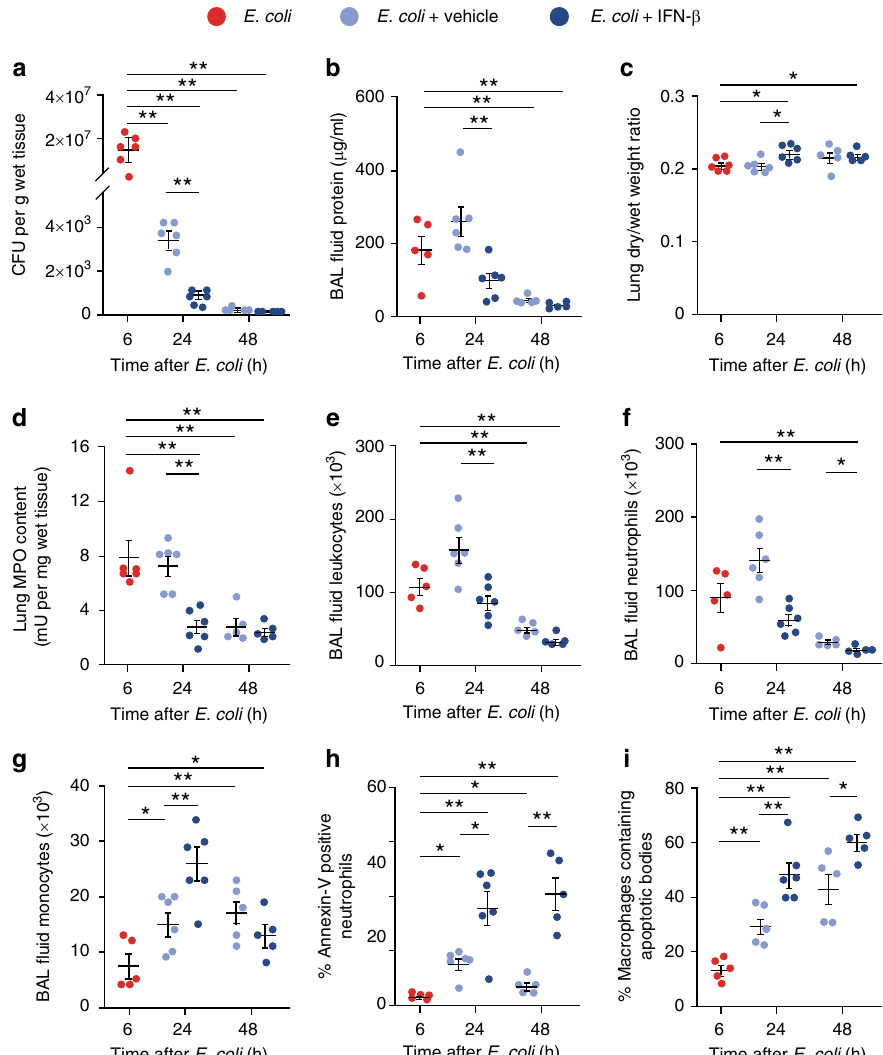
Fig. 8 IFN- β treatment accelerates the resolution of E. coli pneumonia. Female C57BL/6 mice were injected intratracheally with 5*10 6 live E. coli . Six hours later (at the peak of in fl ammation), they were treated with mouse recombinant IFN- β (50 ng/20 g b.w., intraperitoneally) or vehicle. At 24 or 48 h post- E. coli instillation, lungs were removed without lavage and analyzed for E. coli content ( a ), lung dry-to-wet weight ratio ( c ) and tissue MPO activity ( d ). In separate groups of mice bronchoalveolar lavage fl uid protein concentration ( b ), total leukocyte ( e ), neutrophil ( f ) and monocyte/macrophage numbers ( g ), the percentage of annexin-V-positive (apoptotic) PMN ( h ), and the percentage of macrophages containing apoptotic bodies ( i ) were determined. Results are means ± SEM ( n = 6 mice per group for 6 and 24 h and 5 mice per group for 48 h). * P < 0.05, ** P < 0.01 (Dunn ’ s multiple contrast hypothesis